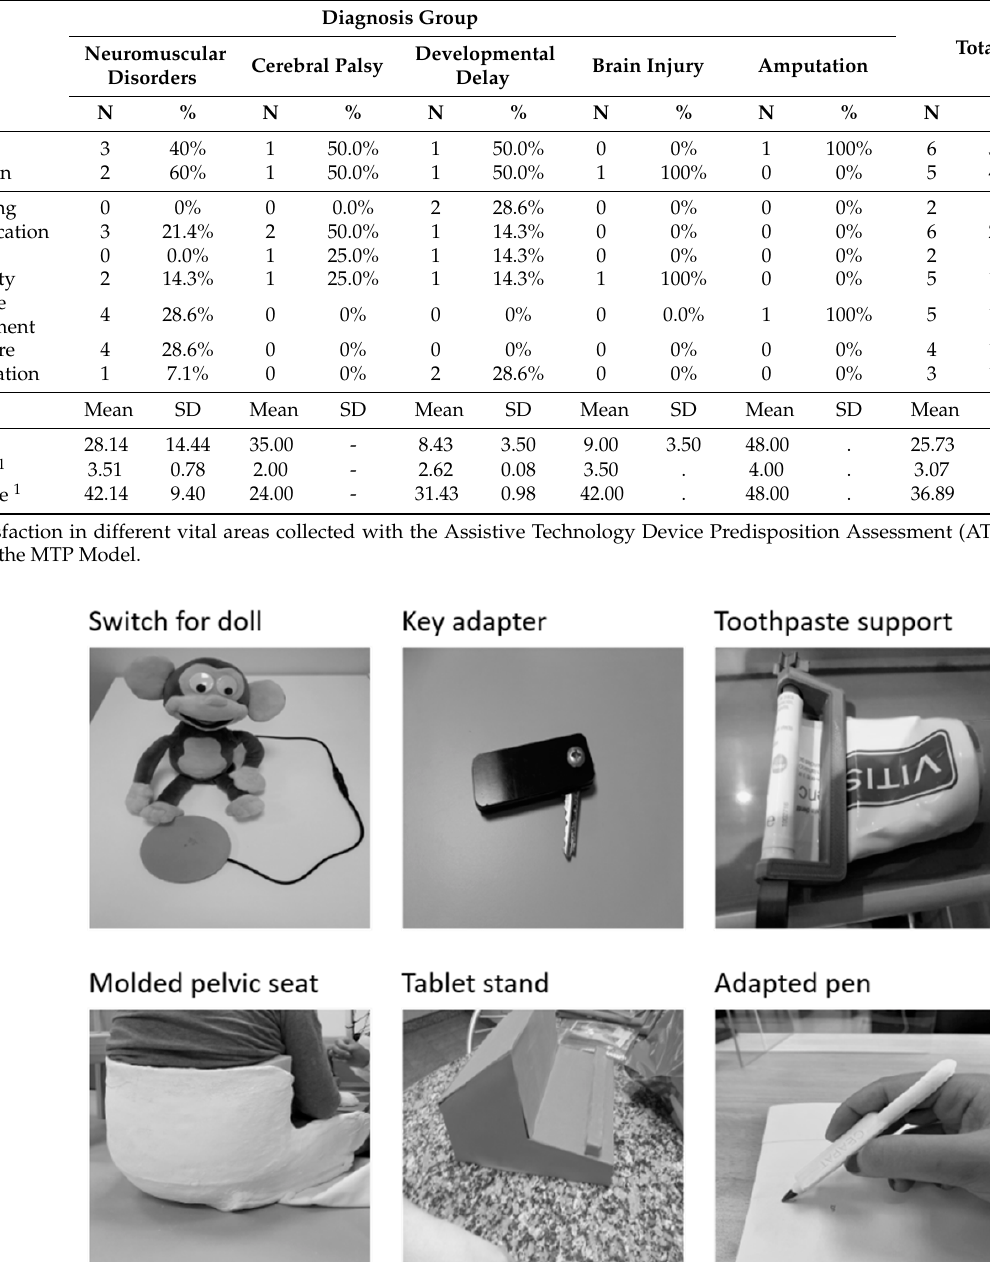
Table 2. Sociodemographic characteristics of the sample.